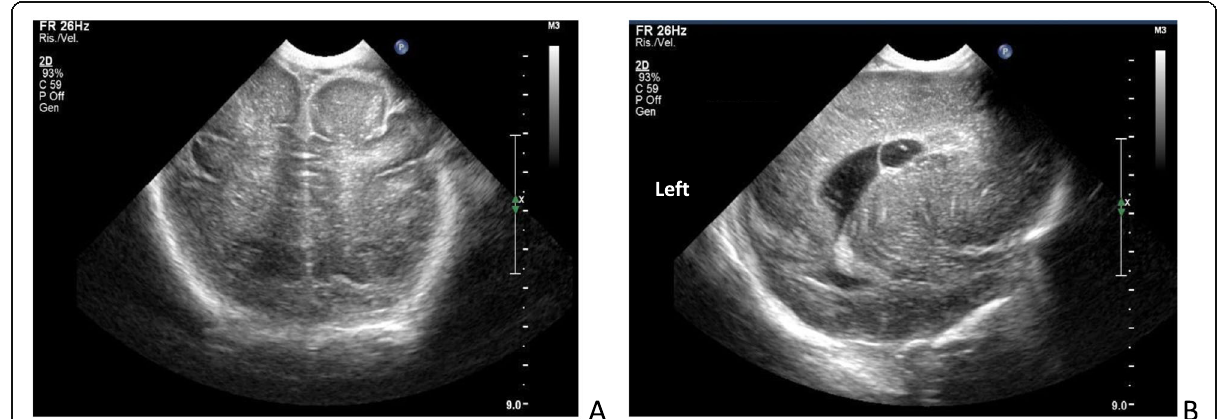
Fig. 1 Cerebral Ultrasound images A: coronal posterior scan shows hyperechoic subcortical white matter; B: lateral sagittal scan shows ventricular pseudocysts and linear hyperechoic striae in basal